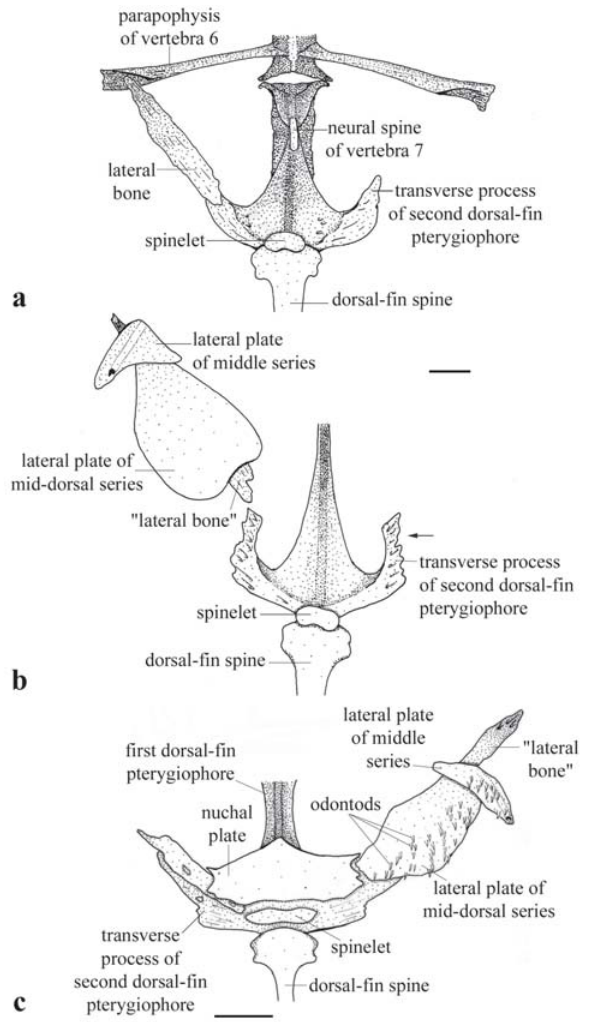
Fig. 46. Dorsal view of second dorsal-fin pterygiophore, spinelet, dorsal-fin spine and lateral bone of Lamontichthys stibaros (FMNH 84111, 62.4 mm SL) (a), Rineloricaria sp. (MZUSP 23748, 91.5 mm SL) (b), and Neoplecostomus ribeirensis (MZUSP 100920, 45.3 mm SL) (c). Scale bar = 1